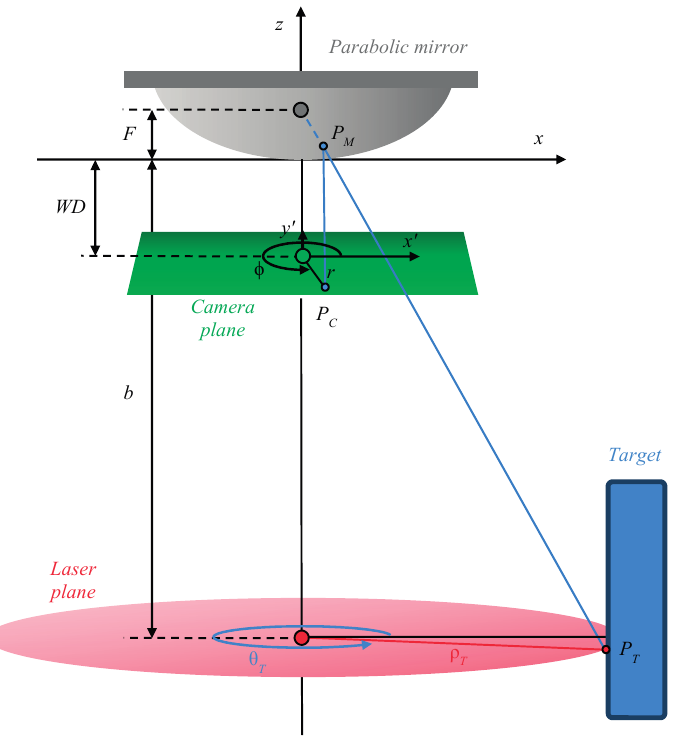
Figure 2. Schematic view of the proposed setup. The final goal of the analytical model is the translation of the known coordinates ( r C , ϕ C ), recovered on the camera plane, in world coordinates ( ρ T , θ T , z T ), having origin in the mirror